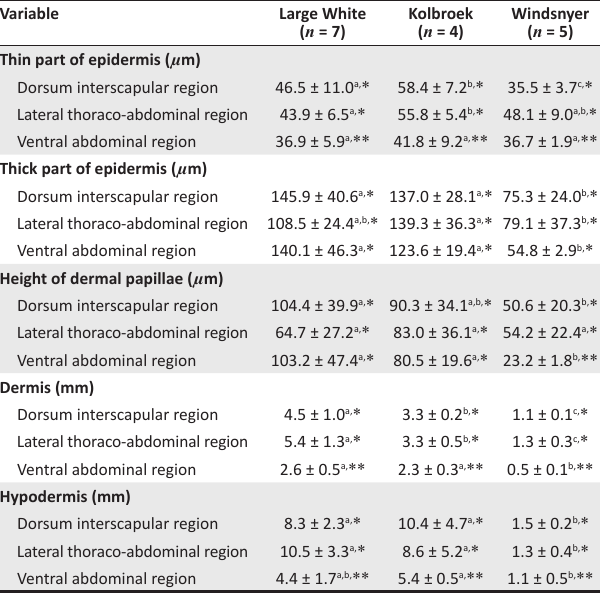
Note: Data are presented as mean ± standard deviation. a, b, c , Values within a row with different superscripts differ significantly at p < 0.05 between the breeds. * , ** , Values within a column with different superscripts differ significantly at p < 0.05 between the body